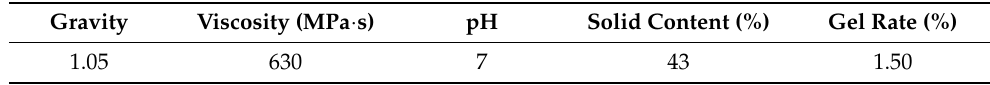
Table 2. Basic physical properties of PVAc.